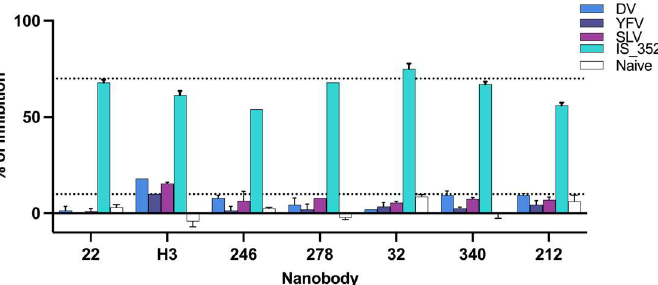
Figure 3. Cross-reactive nanobody inhibition by flavivirus immune sera. Percentages of inhibition achieved for each nanobody by immune serum pools of: Dengue Virus (DV), Yellow Fever Virus (YFV) and Saint Louis Virus (SLV), compared to those generated by WHO IS 16_352 standard and naïve serum. Dotted lines correspond to 10% and 70% of binding inhibition. Measurements are the average of duplicates.